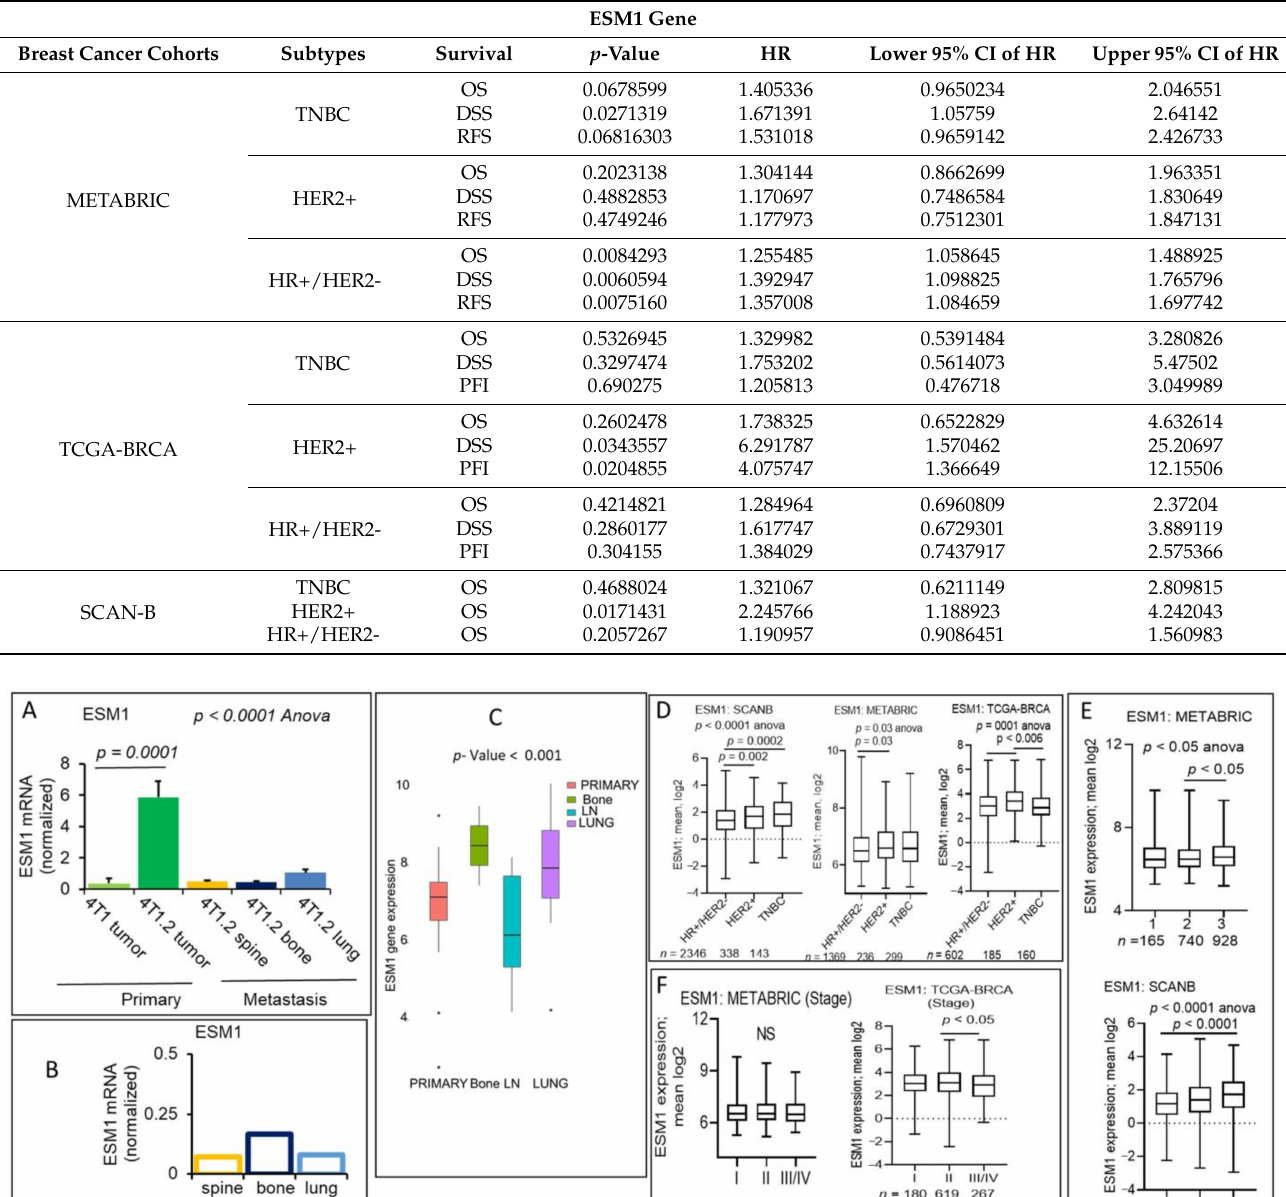
Table 2. ESM1 expression and survival data in breast cancer subtypes.